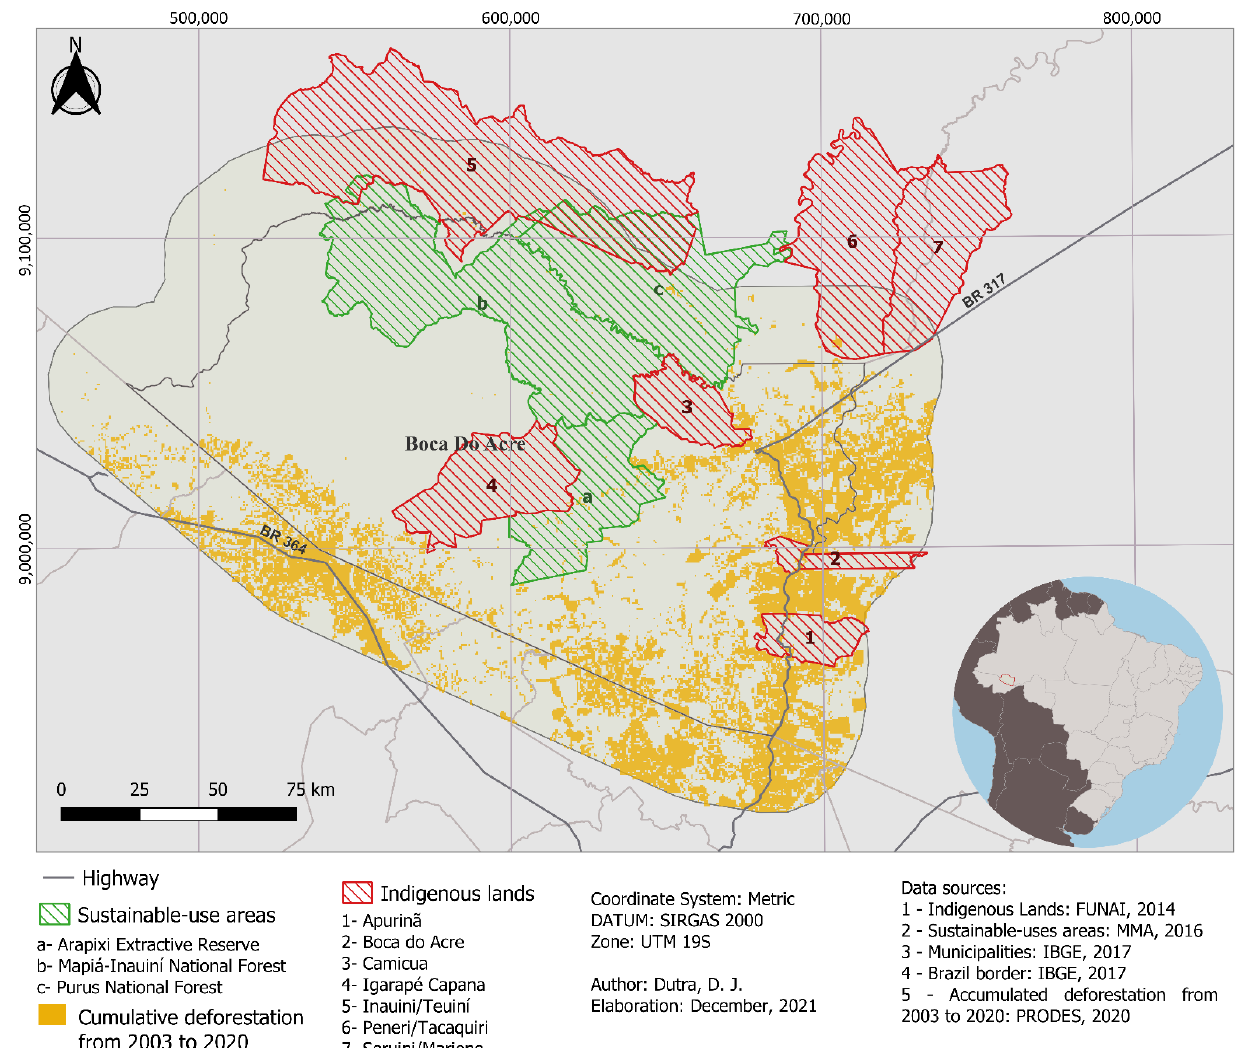
Figure 1. Location of the study area and identification of conservation units (sustainable-use areas) and indigenous lands.